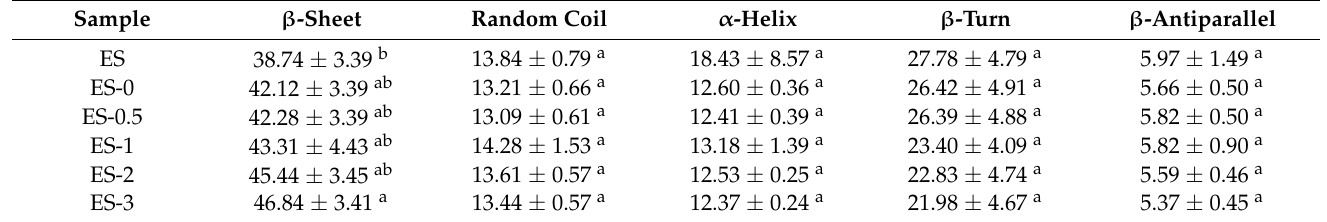
Table 8. Secondary structure percentage (%) analysis of Esox lucius scale gelatin by analyzing the areas of 1600–1700 cm − 1 in FTIR spectra.